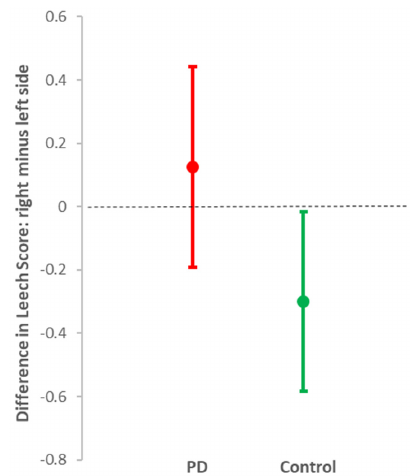
Figure 3. Contrast of mean (95% CI) Leech Score for faecal loading on the right side of the colon compared with left, in those with diagnosed PD (red) and controls without PD (green).